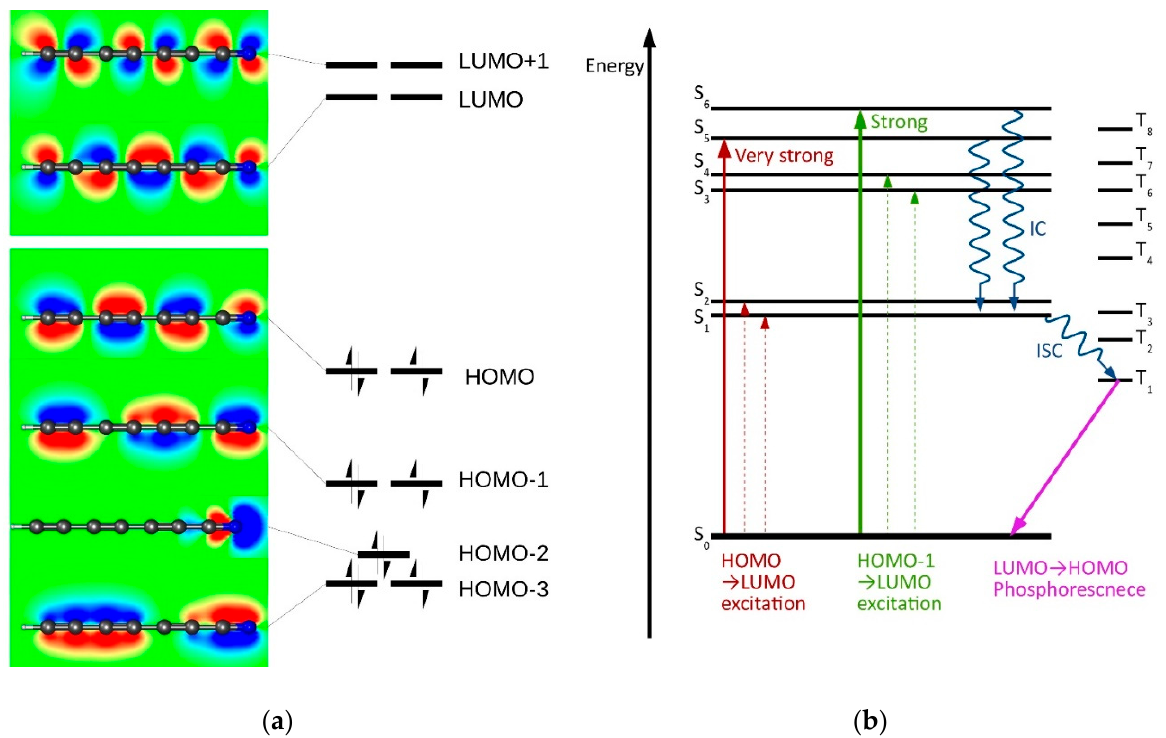
Figure 1. Photophysics of polyynes, illustrated with the example of HC 7 N. ( a ) The predicted contours of molecular orbitals together with a scheme of ground-state orbital occupation; ( b ) Jablonski diagram. Dashed arrows represent weak, formally forbidden transitions.